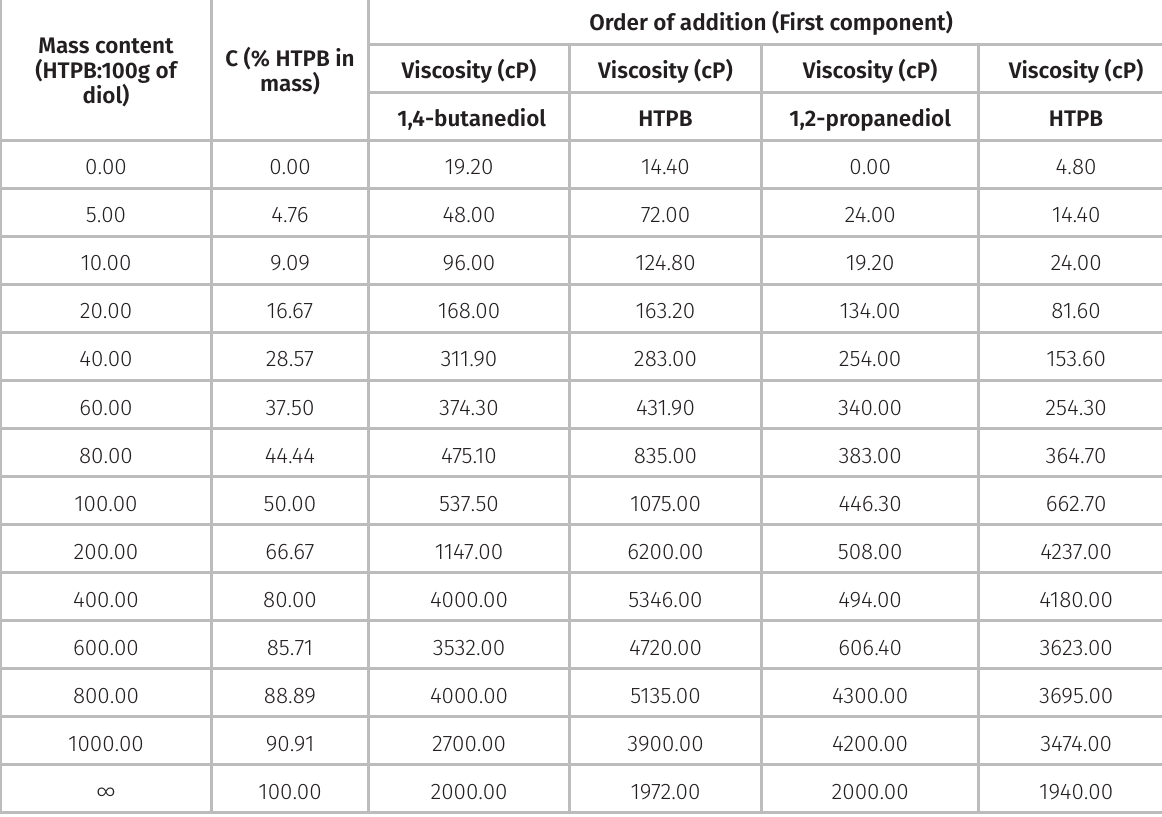
Table I. Viscosity data obtained from 1,4-butanediol or 1,2-propanediol and HTPB solutions. Order of addition (First component) Mass content C (% HTPB in Viscosity (cP) Viscosity (cP) Viscosity (cP) Viscosity (cP) (HTPB:100g of mass) diol)